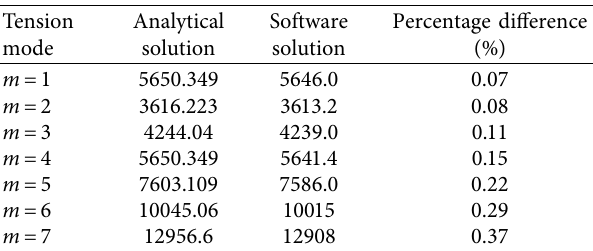
Table 6: Percentage difference of software solution and analytical solution for other tension mode